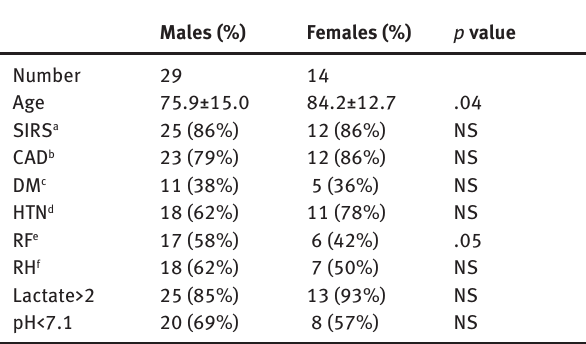
Table 1: Unexpected Death within 24 Hours; Clinical and Biochemi- cal